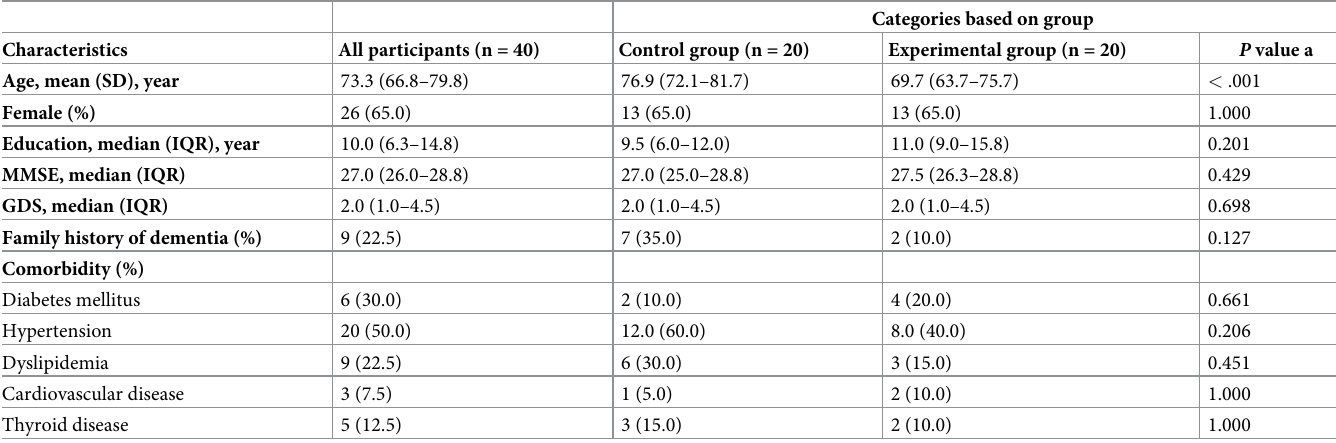
Table 1. Demographic characteristics of